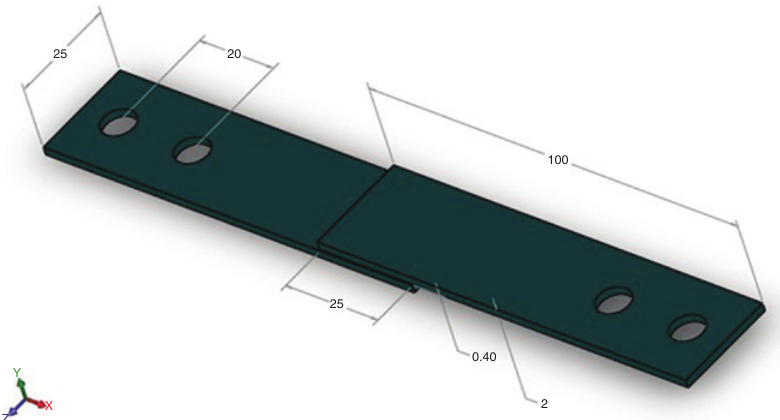
Figure 2: The geometrical illustration of the specimen with dimensions.